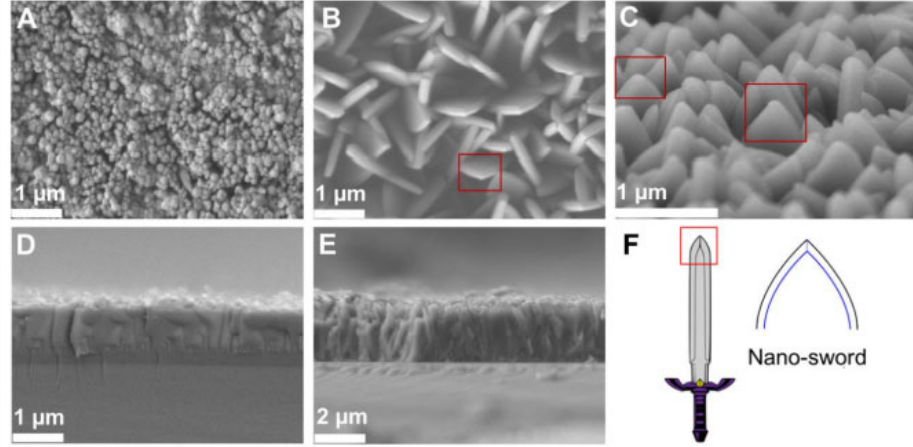
Figure 14. SEM images of ZIF ‐ coated glass: ( A , D ) top view and side view of 2 ‐ MeIm:Zn of 35:1; ( B , C , E ) top, tilted, and side view of 2-MeIm:Zn of 7:1; red rectangle showing edge of the dagger-like ( B , C , E ) top, tilted, and side view of 2 ‐ MeIm:Zn of 7:1; red rectangle showing edge of the dagger ‐ like structure ( F ) Illustration showing the dagger-like structure of ZIF-L with a ratio of 2-MeIm:Zn of 7:1. structure ( F ) Illustration showing the dagger ‐ like structure of ZIF ‐ L with a ratio of 2 ‐ MeIm:Zn of Reproduced with permission from 7:1. Reproduced with permission from [98] .